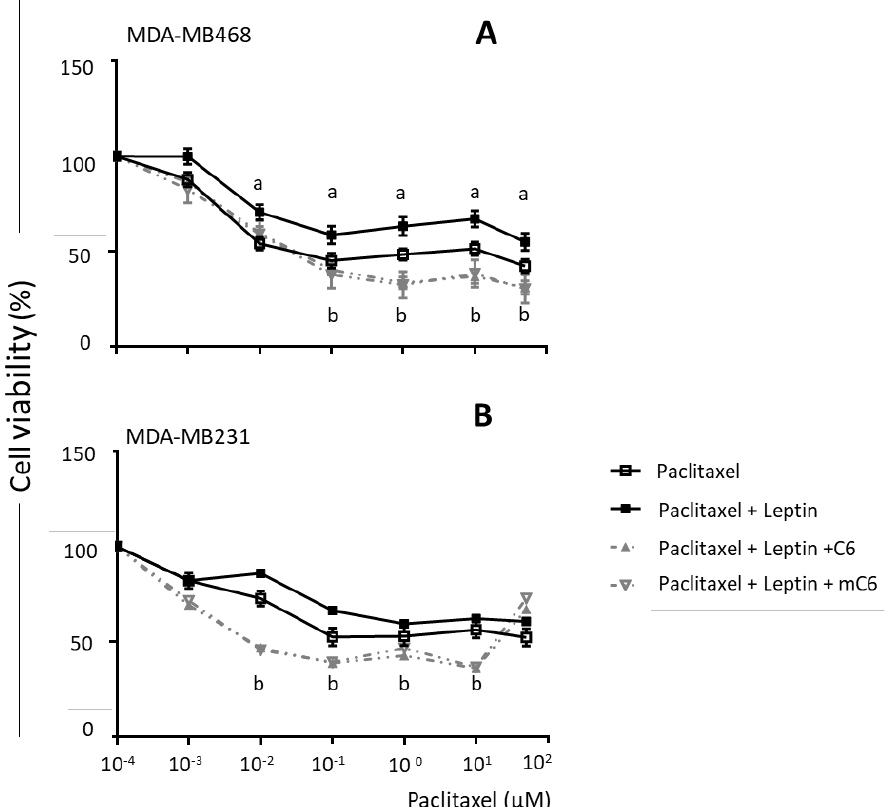
Figure 5. Leptin treatment increases survival of triple-negative breast cancer cells treated with paclitaxel. Paclitaxel dose–response e ff ects on breast cancer cell survival: ( A ) MDA-MB468 and ( B ) MDA-MB231. Cells were treated with paclitaxel (P, 10 − 4 –10 2 µ M); P + Leptin (L, 2.5 nM) and P + L + C6 and mC6 leptin antagonists (2.5 nM) for 72 h. CellTiter-Glo Assay was used to determine relative cell survival; “a”: p ≤ 0.05 compared to P; “b”: p ≤ 0.05 compared to P + L.